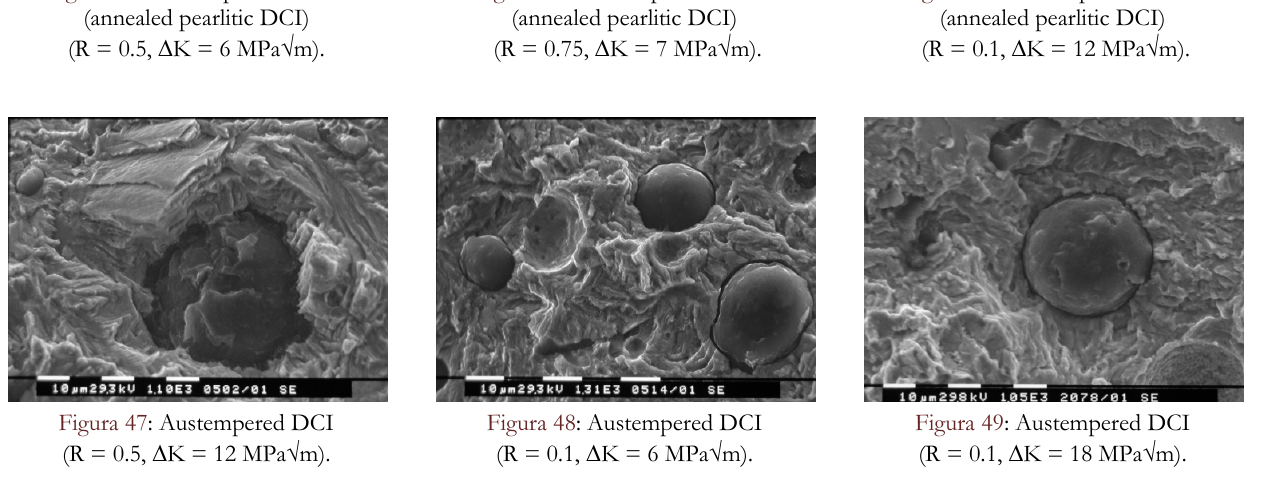
Figure 44: Ferritic-pearlitic DCI (annealed pearlitic DCI) (R = 0.5,  K = 6 MPa √ m).